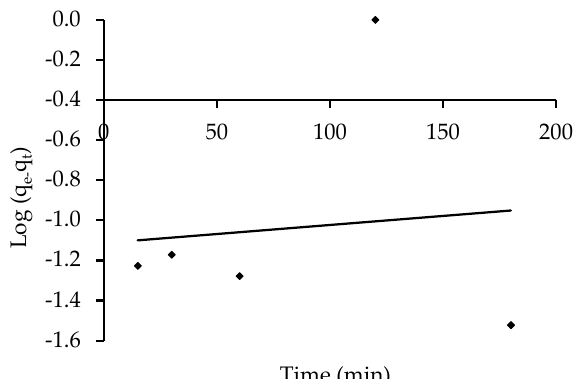
Figure 15. Adsorption kinetics of the pseudo ‐ first ‐ order kinetics of IV2R adsorption onto the ZnO ‐ NPs. Table 5. Parameters of the different adsorption kinetic models.